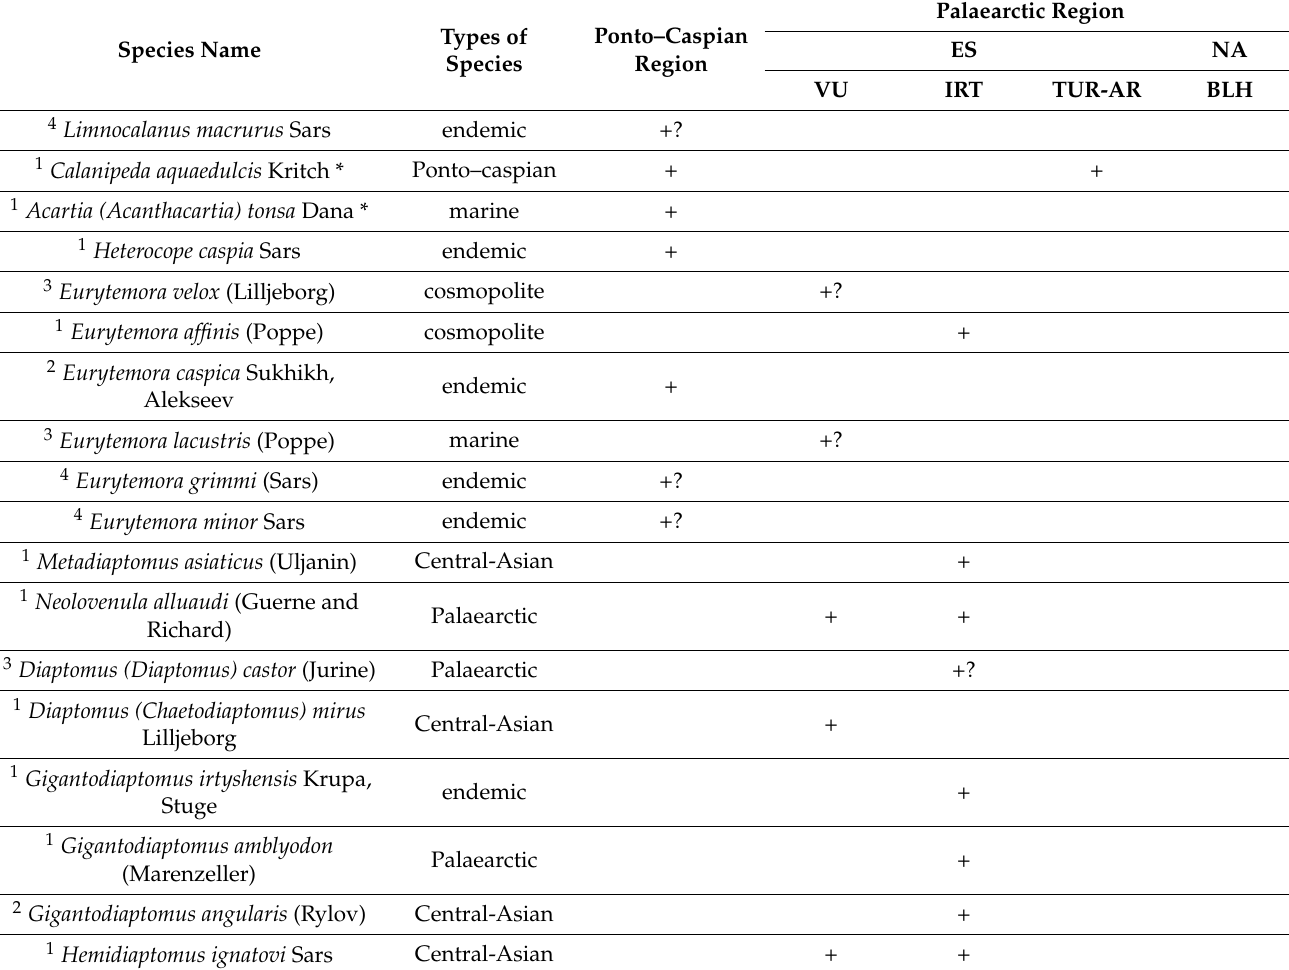
Table 3. Species composition and zoogeographic distribution of Calanoida species in Kazakhstan.